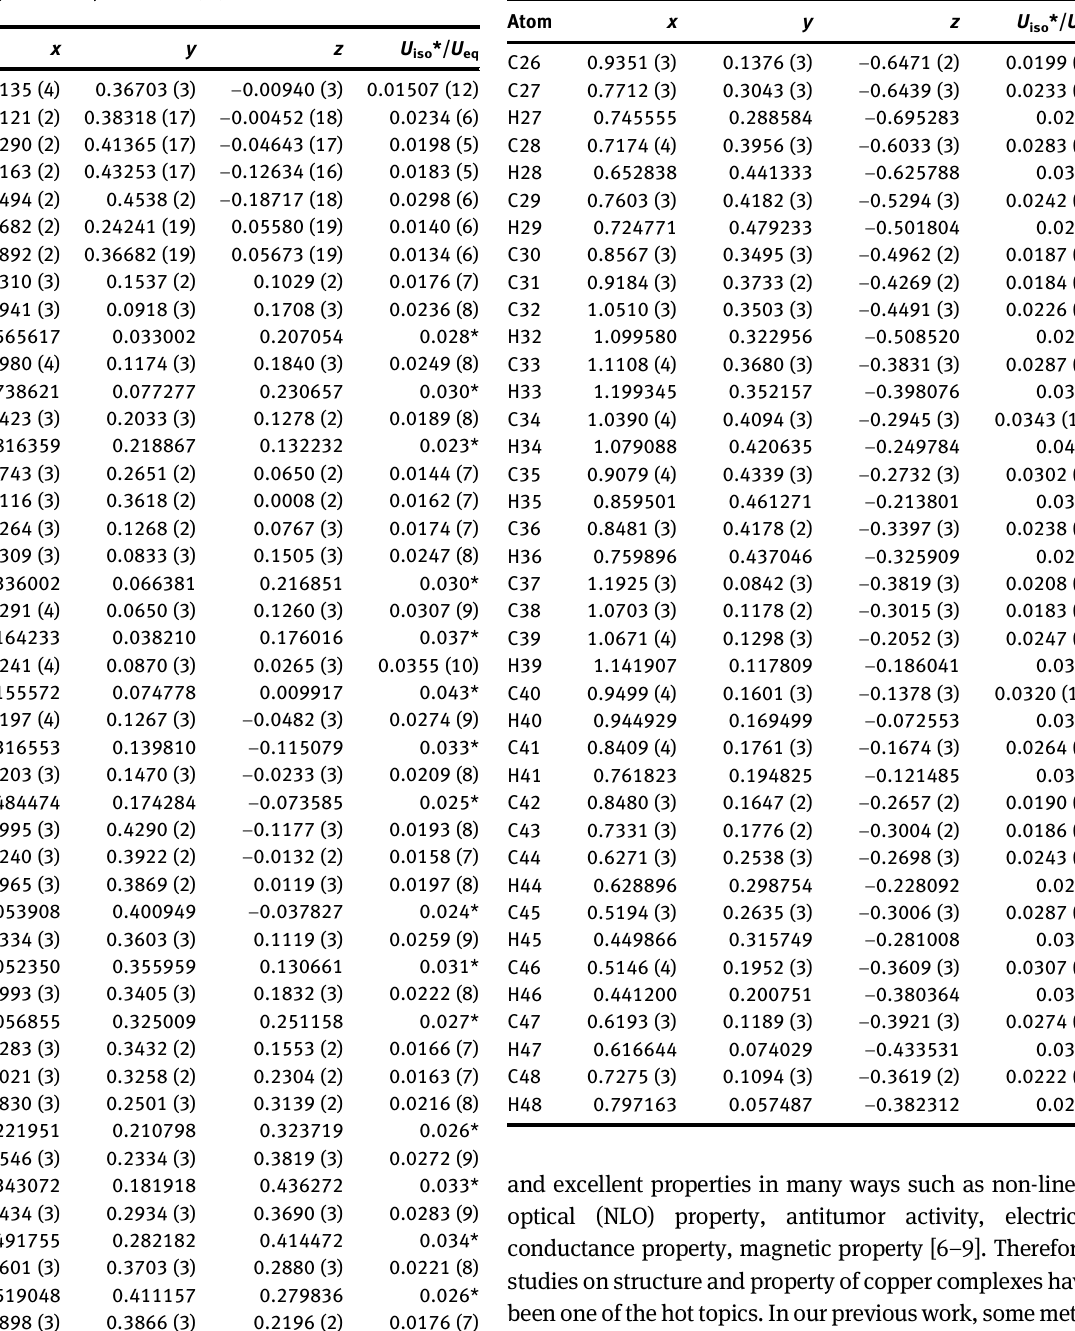
Table  : Fractional atomic coordinates and isotropic or equivalent isotropic displacement parameters (Å 